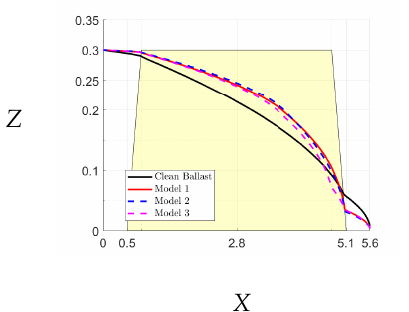
Figure 16. Free-surface for realistic railway ballast at height h 1 = 0.3.